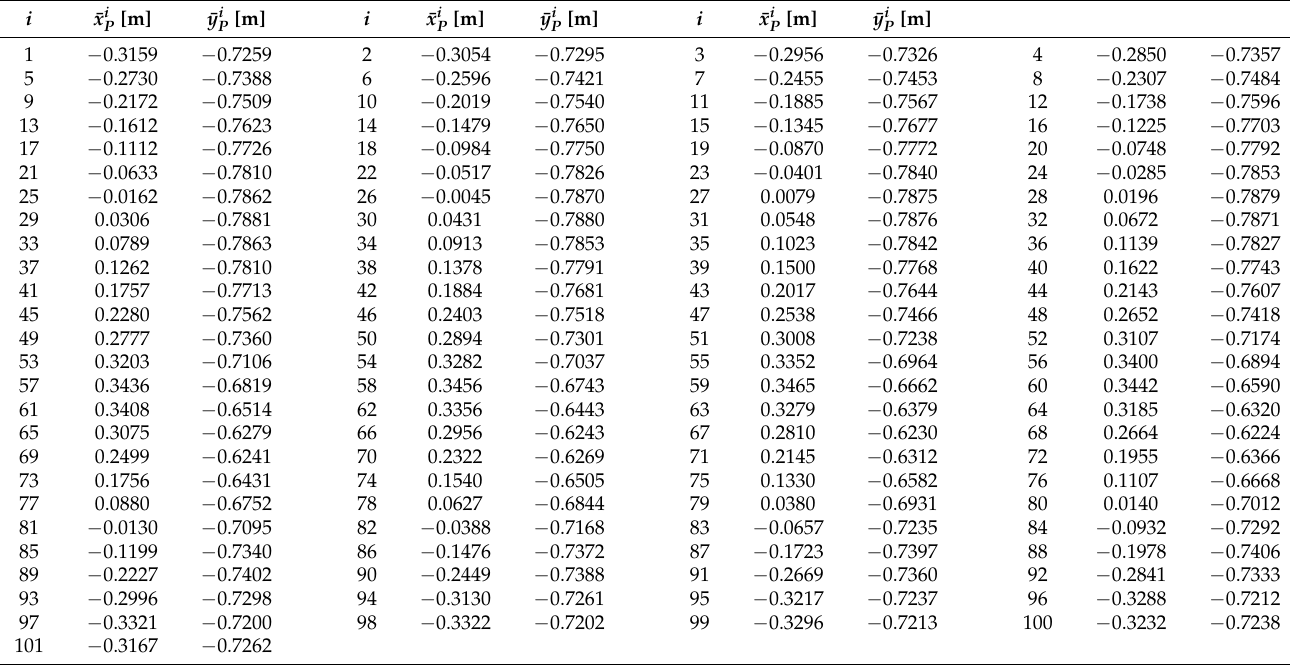
Table A2. Precision points for study case 2: Cam-linkage